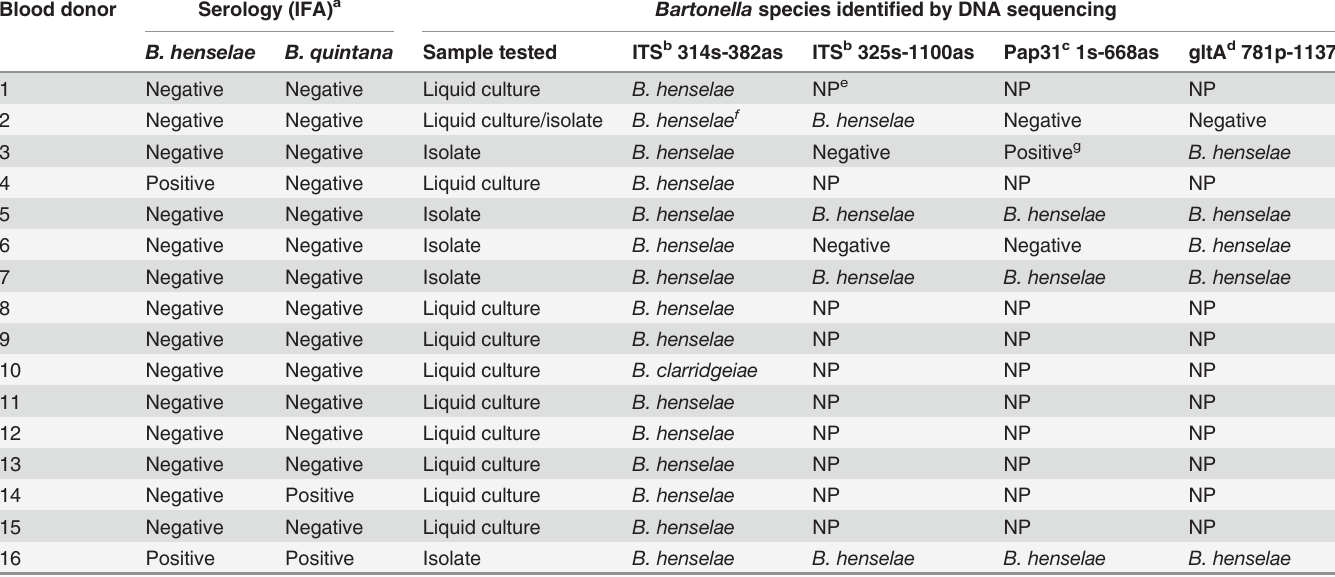
Table 1. Serology and DNA sequencing results of 16 blood donors tested for exposure or infection with Bartonella species. Blood donor Serology (IFA) a Bartonella species identi fi ed by DNA sequencing